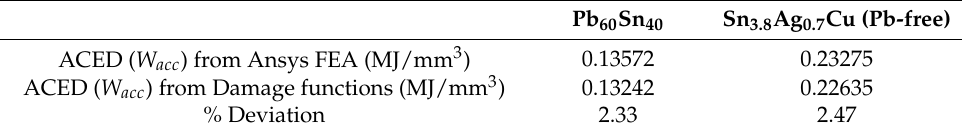
Table 6. Comparative analysis of ACED damage from FEA and damage functions.